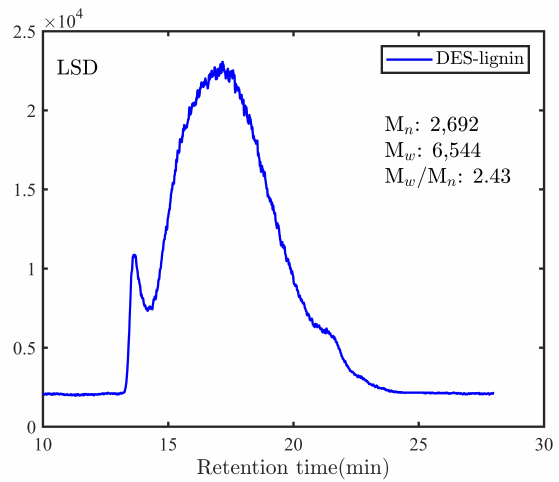
Figure 1. Molar mass distribution and average molecular weight of